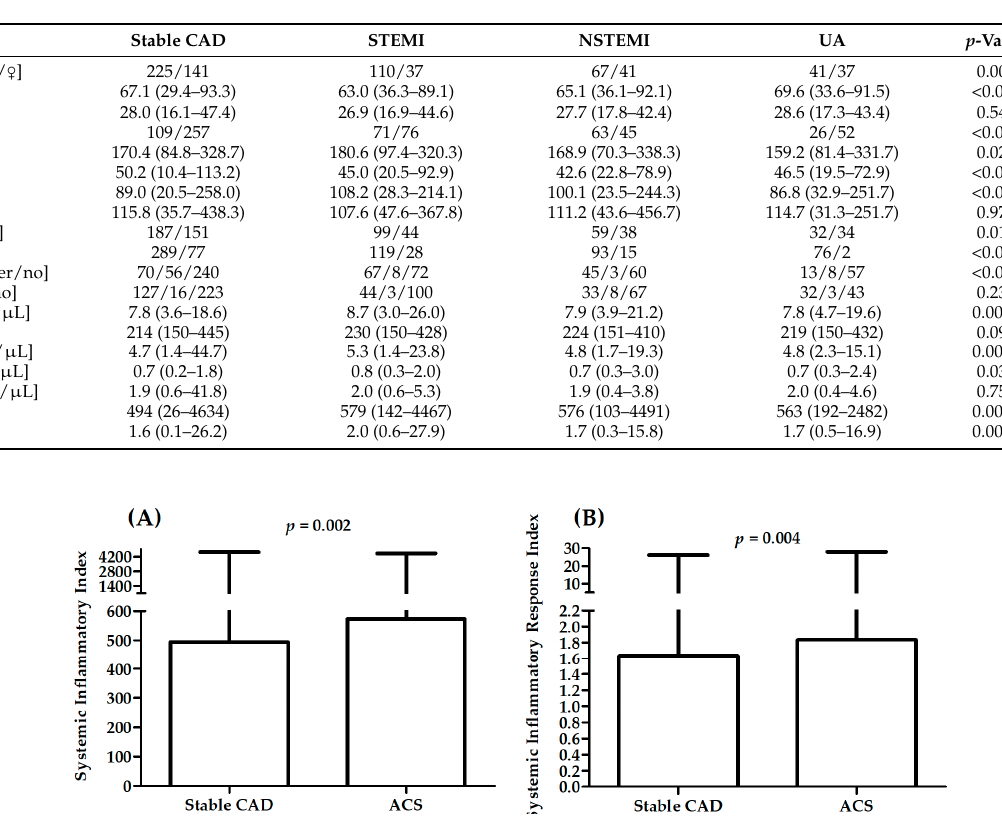
Table 3. Differences in selected parameters between patients with different diagnosis.